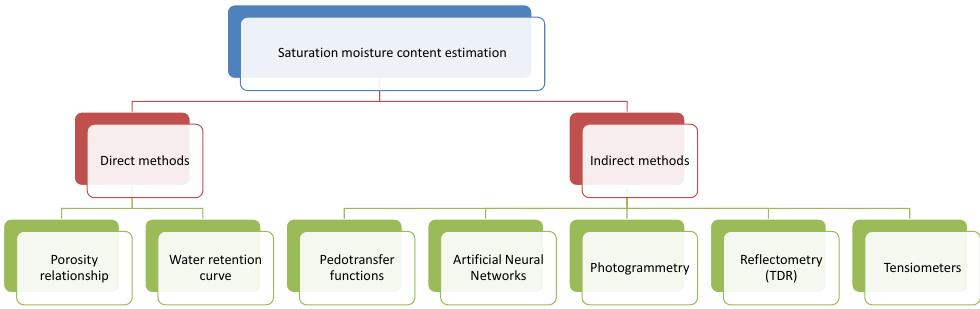
Figure 1. Main methods used in the saturation moisture content